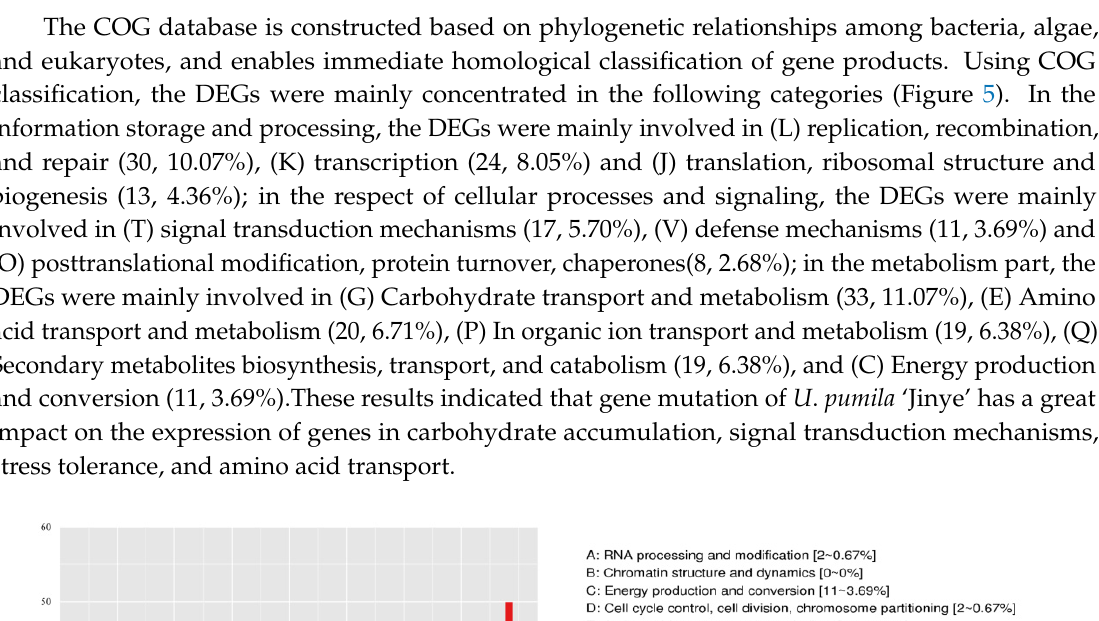
Figure 6. Eukaryotic orthologous group (KOG) annotation classification of DEGs.